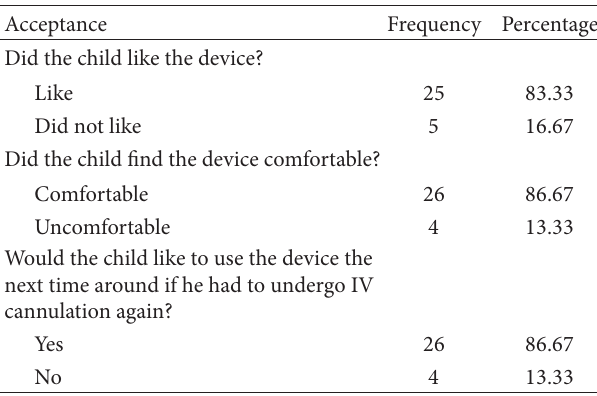
Table 4: Acceptance of HEADPLAY PCS